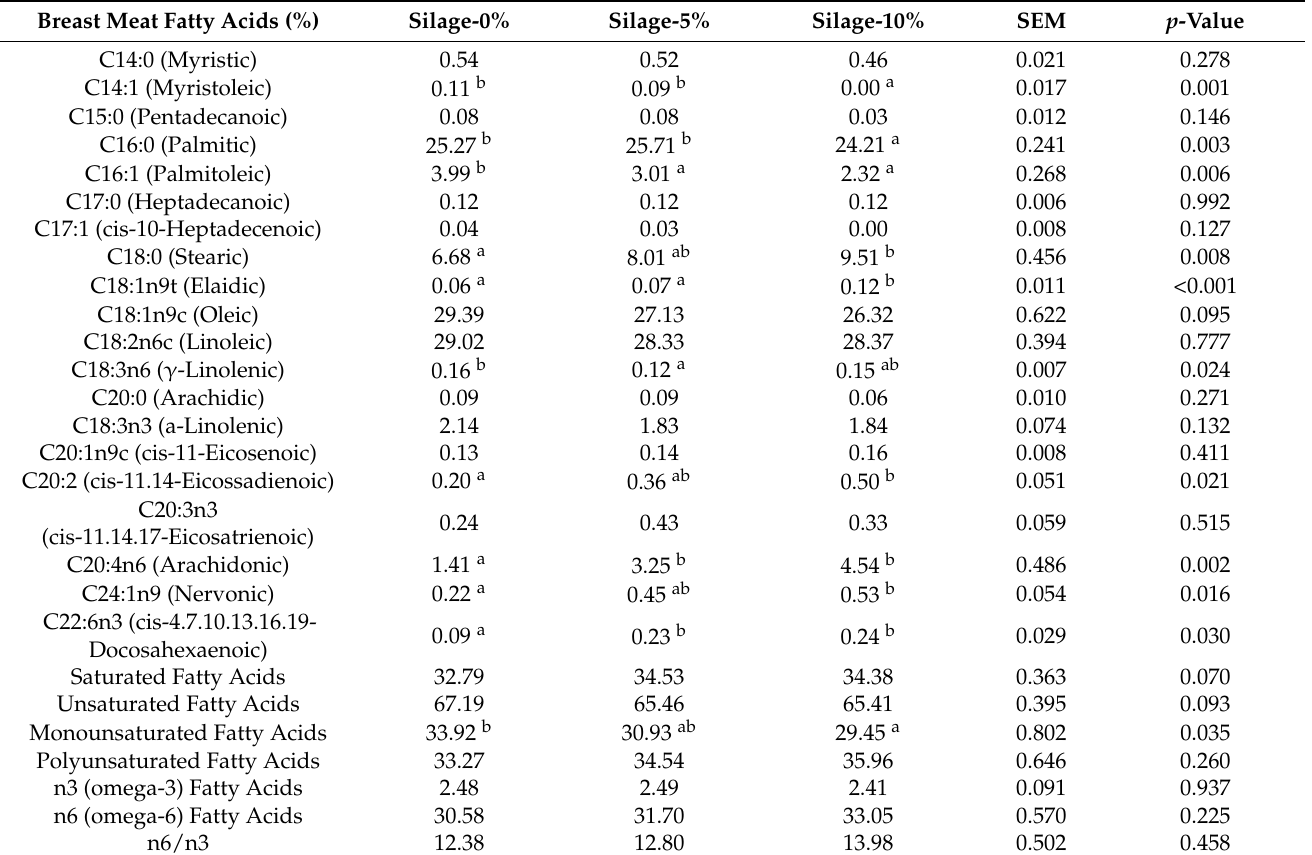
Table 9. Effect of silage supplementation on broiler breast meat fatty acid